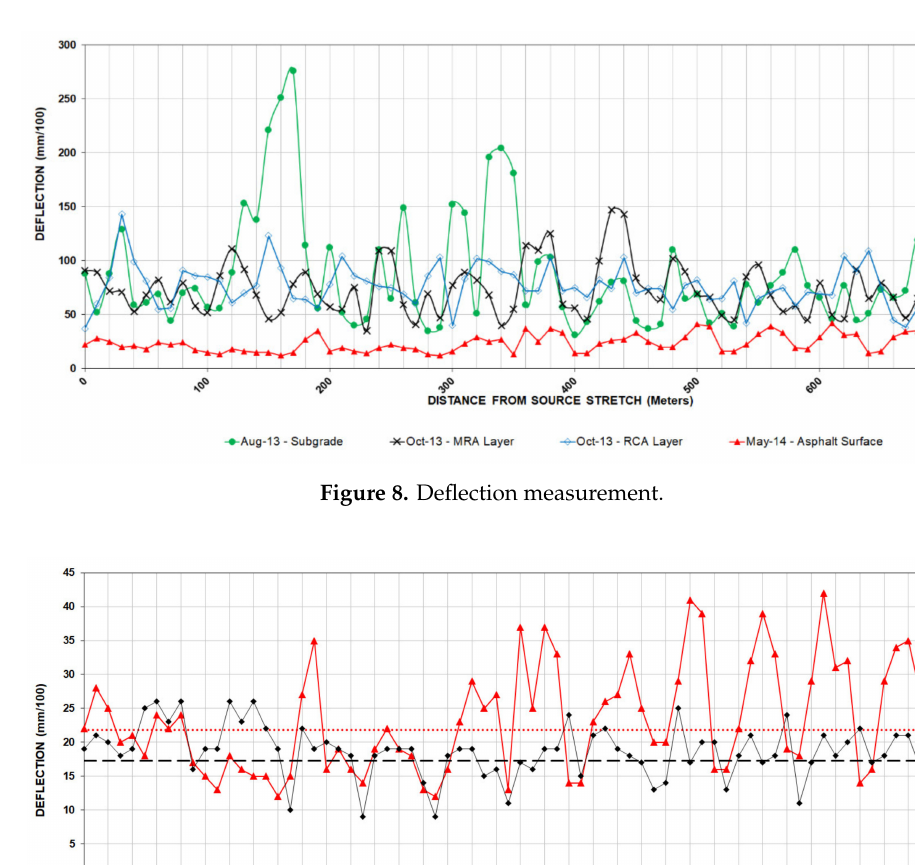
Figure 7. Lanes of the experimental platform.